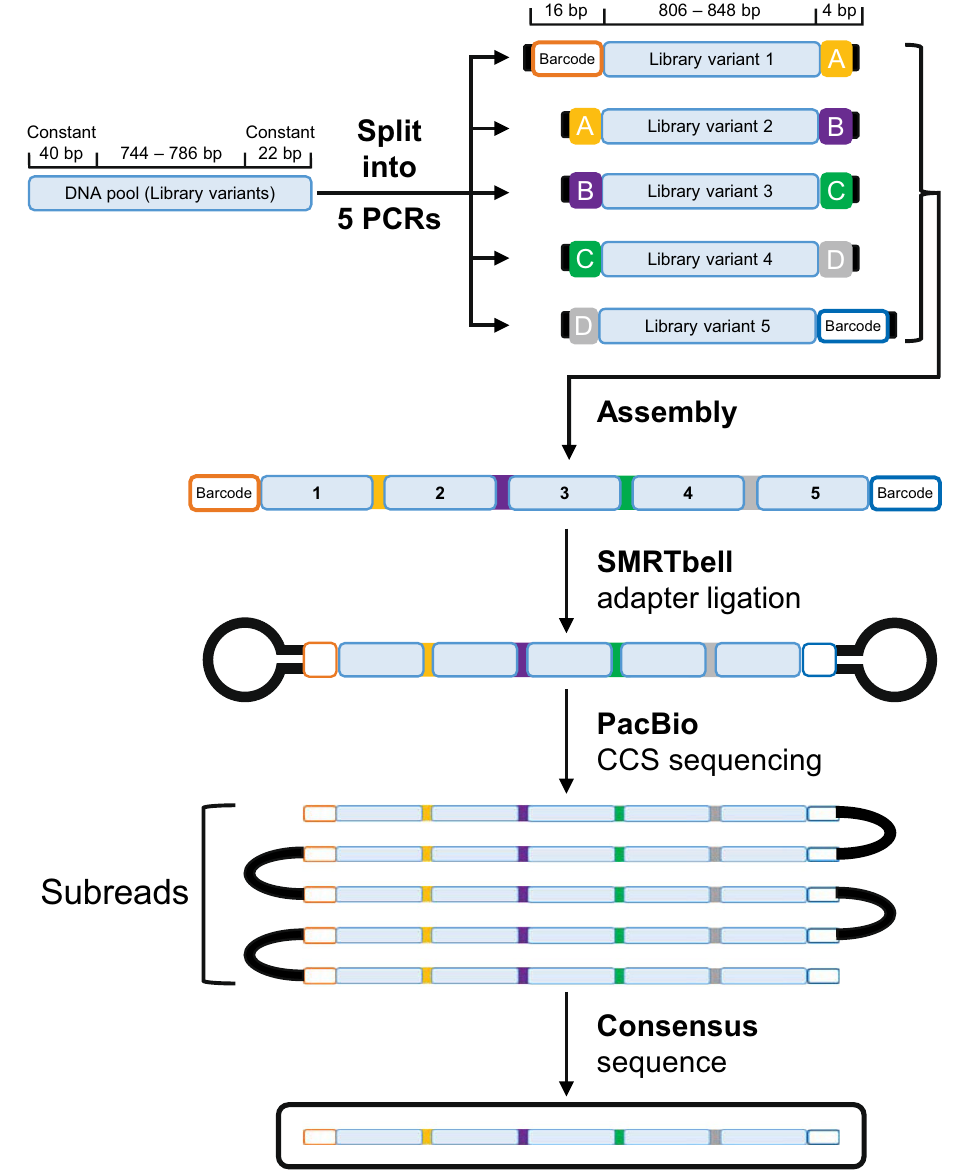
Figure 1. Overview of the concatenation procedure. The DNA pool to be sequenced was split into five PCR reactions with distinct primer sets, producing library variants 1–5. The PCR reactions also appended the variants with complementary BsaI restriction sites, which contained the four unique scar sequences ( A – D ) (yellow, purple, green, grey). The complementary overhangs are shown as black rectangles. Sample-specific barcodes were attached to the 5 ′ -end of library variant 1 and the 3 ′ -end of variant 5. The design enabled controlled and directional assembly of the five library variants upon Golden Gate assembly. The different barcoded concatemers were all combined and SMRTbell hairpin adapters were ligated to the barcodes of each amplicon. PacBio CCS sequencing and the SMRTbell hairpin adapters allowed continuous reads of the large concatemer amplicons producing several subreads. The consensus of the subreads produced high fidelity sequence